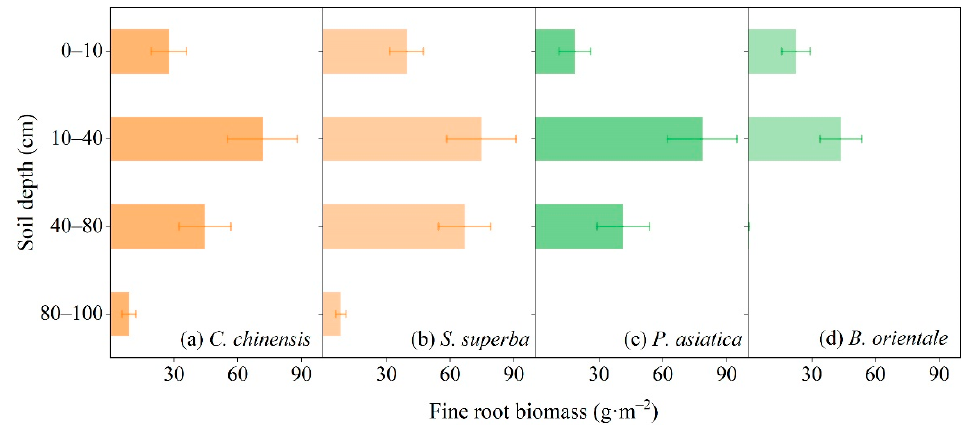
Figure 4. Fine root biomass of the four different PFTs including Castanopsis chinensis ( a ) , Schima superba ( b ) , Psychotria asiatica ( c ), and Blechnum orientale ( d ) in the monsoon evergreen broad-leaved forest.